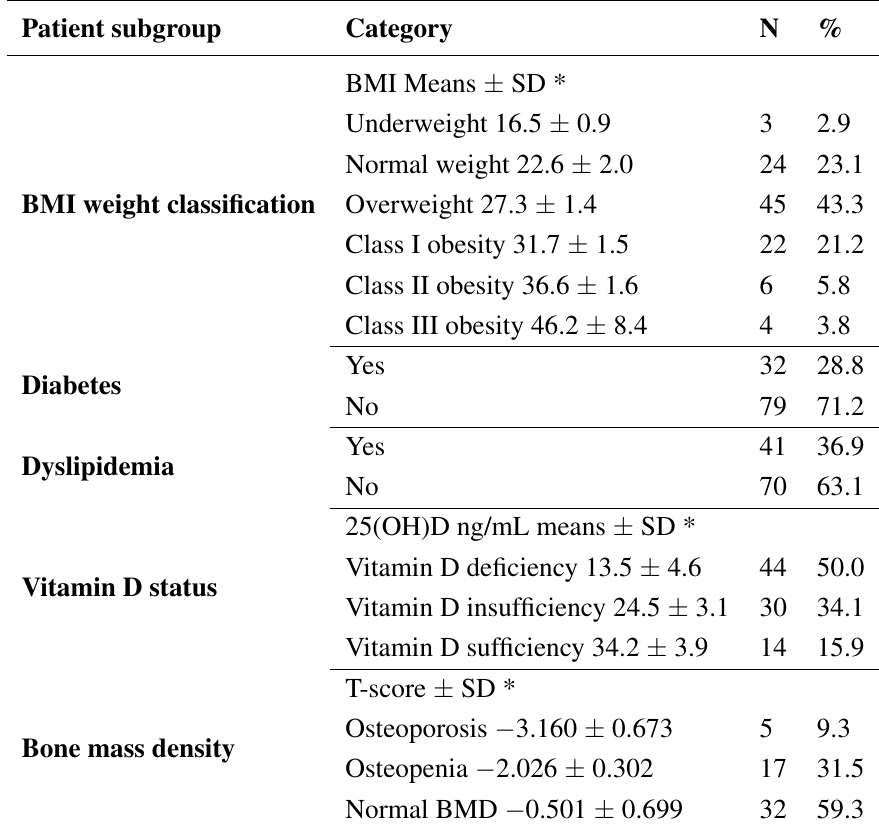
Table 2. Patient subgroup classification According to BMI, Dyslipidemia, Diabetes, Vitamin D status and